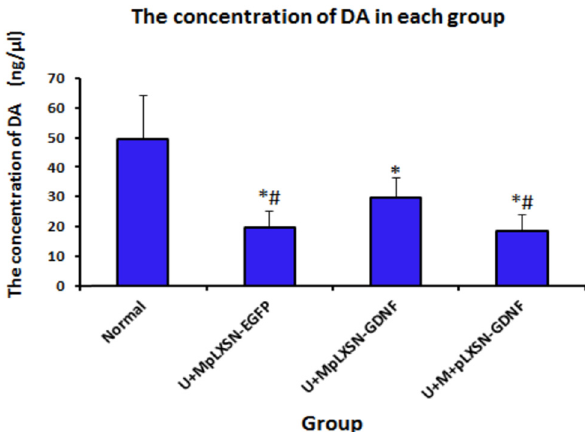
Figure 5: Determination of DA concentration in each group by HPLC. Compared with the normal group ** P < 0.01, * P < 0.05, compared with the U + MpLXSN - GDNF group # P <